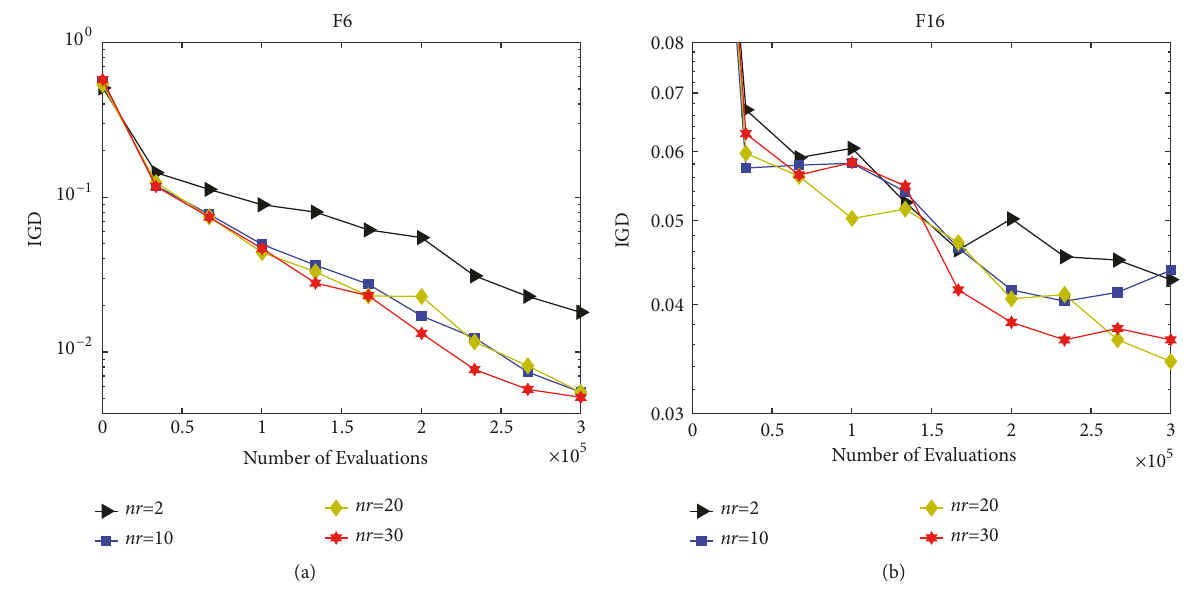
Figure 10: Parameter sensitivity studies of nr on (a) F6 and (b)